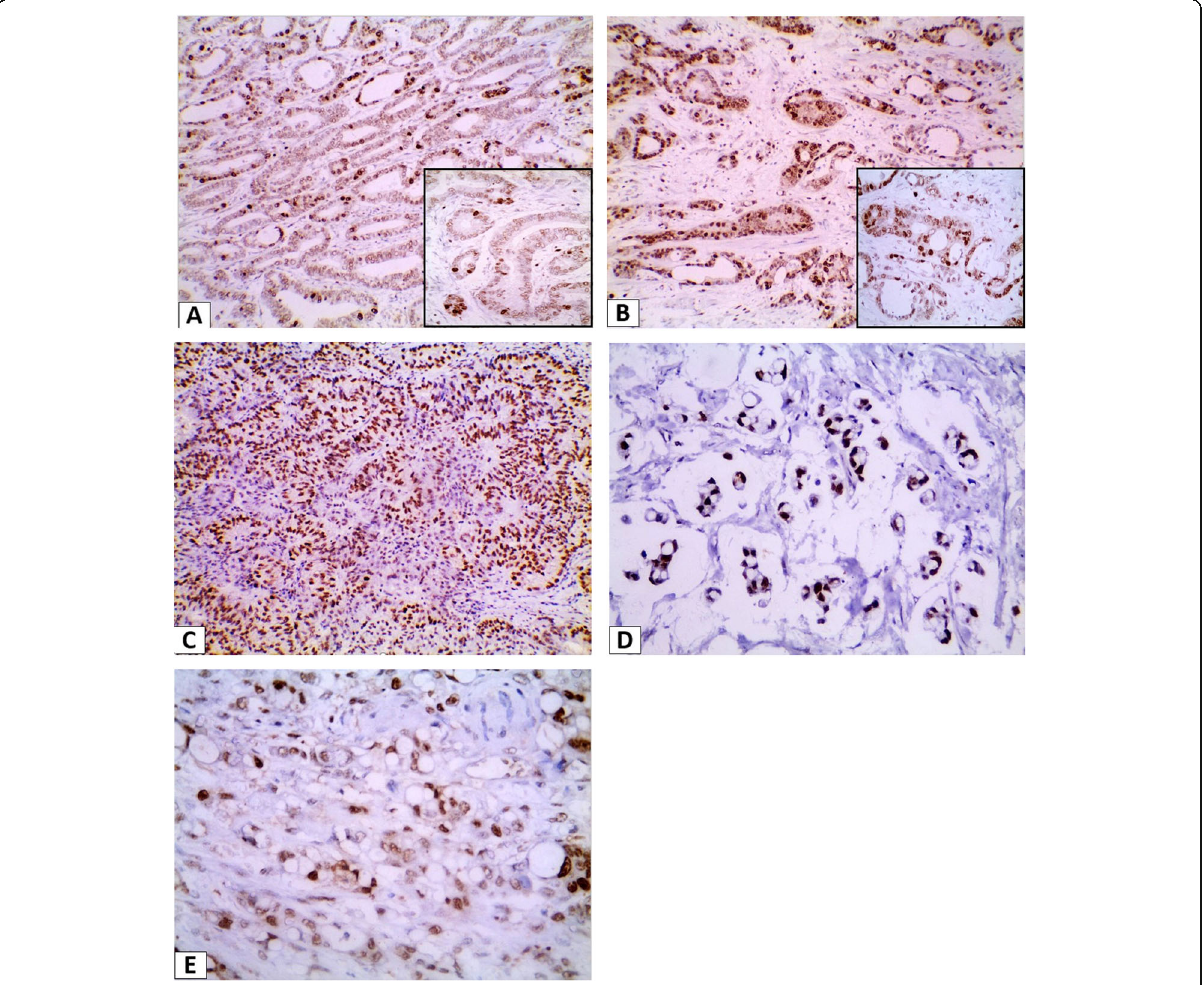
Fig. 1 Oct4 immunohistochemical expression in gastric carcinoma cases: a Low Oct4 expression in well-differentiated gastric carcinoma (× 200) [inset: a higher magnification × 400]. b Low Oct4 expression in moderately differentiated gastric carcinoma (× 200) [inset: a higher magnification × 400]. c High Oct4 expression in poorly differentiated gastric carcinoma (× 200). d High Oct4 expression in mucinous carcinoma (× 400). e High Oct4 expression in signet ring carcinoma (×